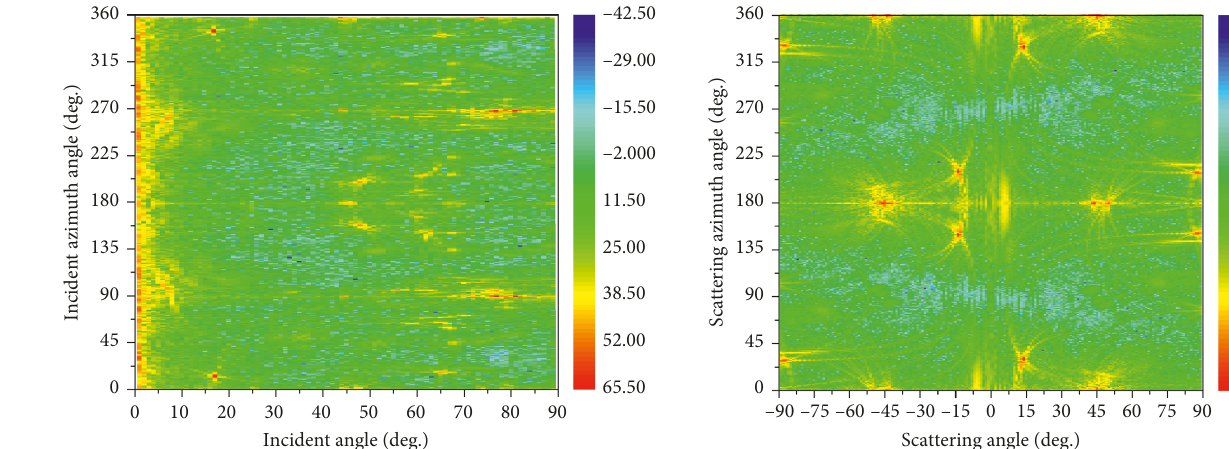
Figure 11: The change of RCS of the ship with incident angle and incident azimuth angle.